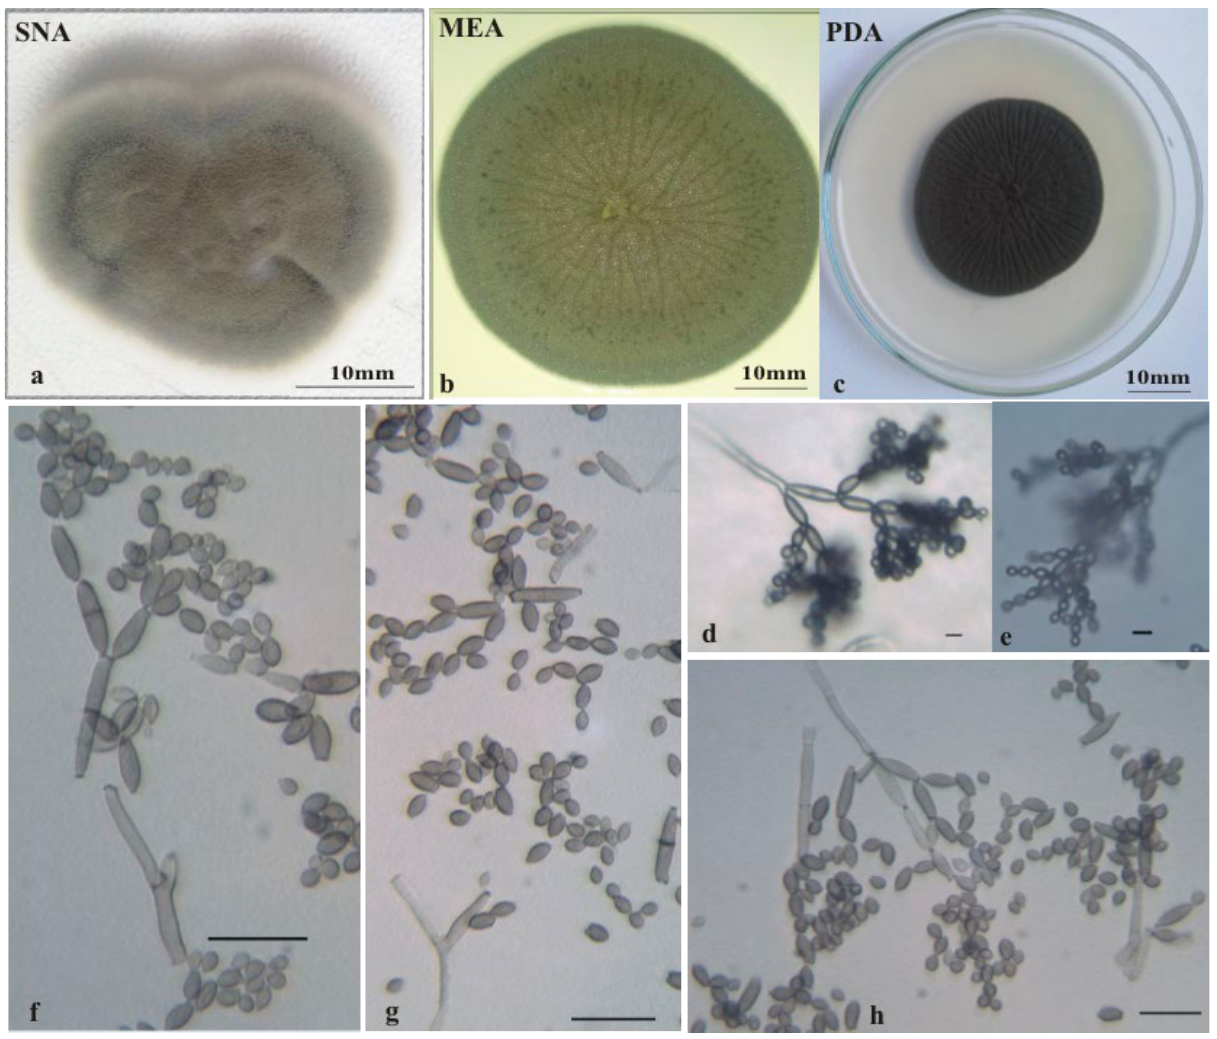
Figure 3. Cladosporium limoniforme : (a) Colony on SNA. (b) colony on PDA. (c) Colony on MEA. (d, e) Conidial chains. (f, g, h) Micronematous conidiophores forming large numbers of conidia. Scale bar = 10